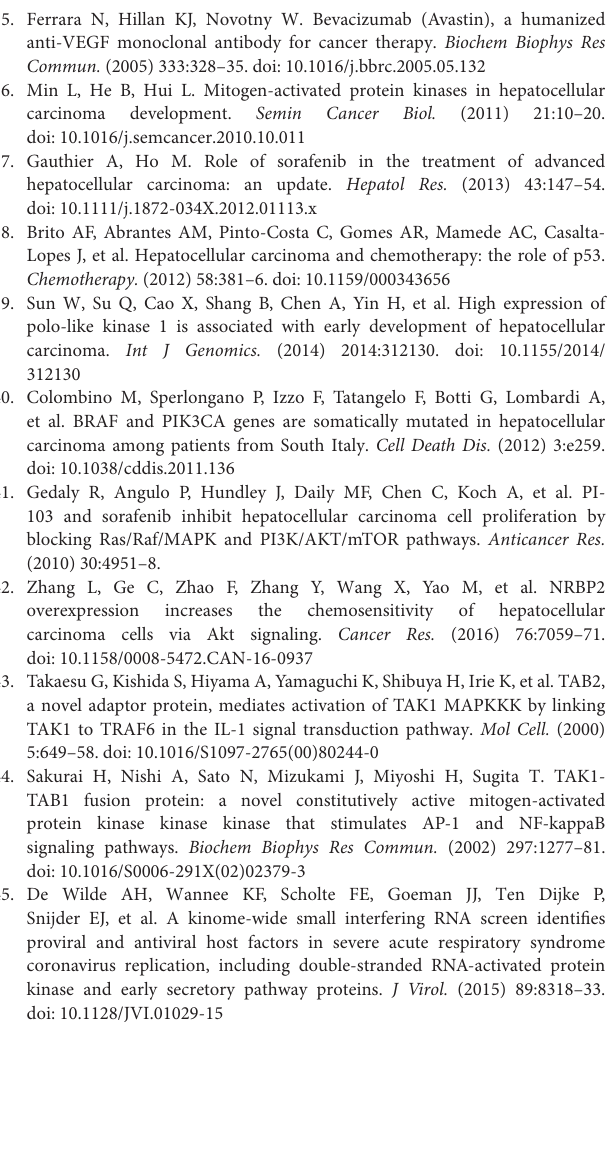
TAB1 fusion protein: a novel constitutively active mitogen-activated protein kinase kinase kinase that stimulates AP-1 and NF-kappaB signaling pathways. Biochem Biophys Res Commun. (2002) 297:1277–81. doi: 10.1016/S0006-291X(02)02379-3 45. De Wilde AH, Wannee KF, Scholte FE, Goeman JJ, Ten Dijke P, Snijder EJ, et al. A kinome-wide small interfering RNA screen identifies proviral and antiviral host factors in severe acute respiratory syndrome coronavirus replication, including double-stranded RNA-activated